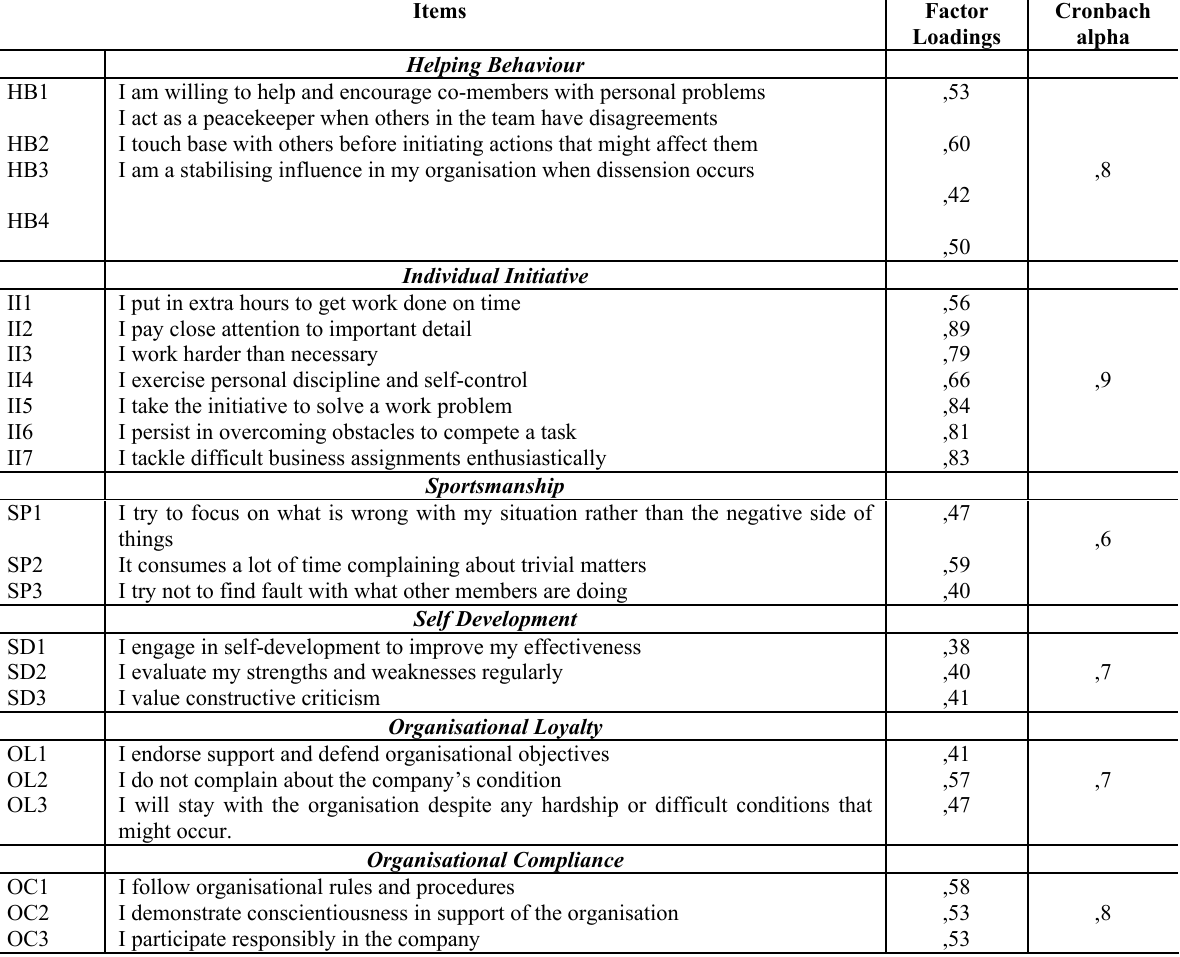
Table 2: Extra-Role Performance Factor Loadings and Construct